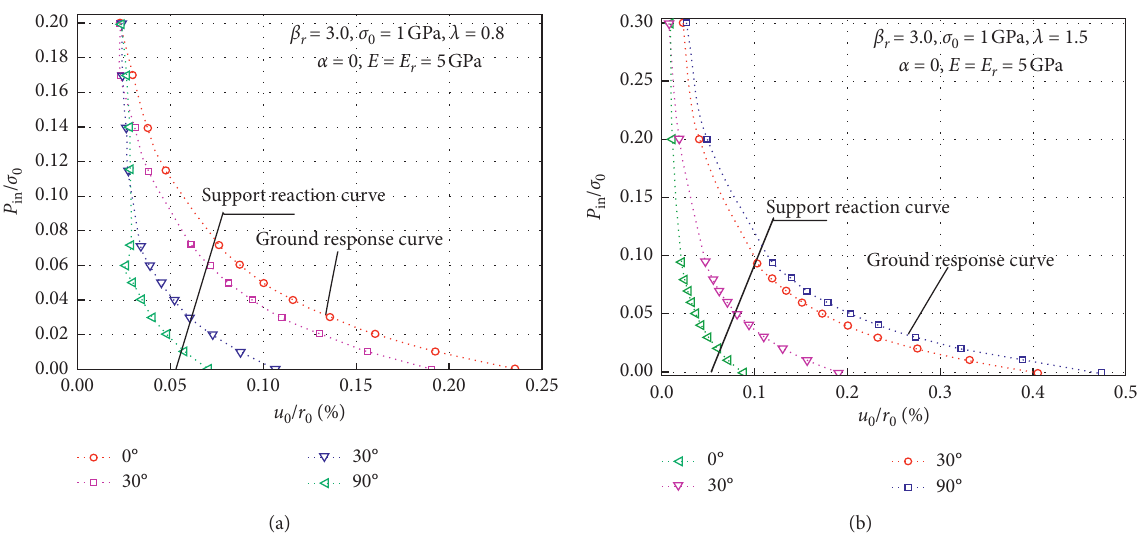
Figure 7: Changes of the response curve between rock wall and support frame with different lateral pressure coefficients. Parameter values: soft rock v � v r � 0 . 2, β r � 3.0, α � 0, and E � E r � 5 GPa. The lateral pressure coefficient of (a) λ � 0.8 and (b) λ �